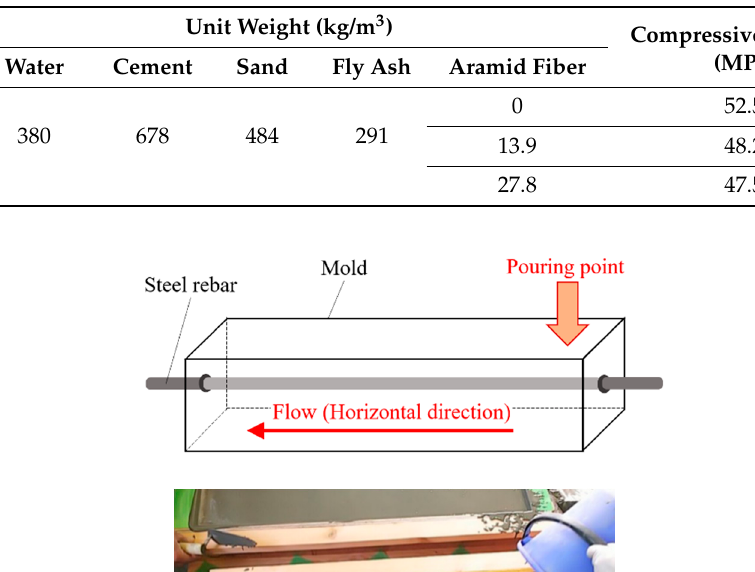
Table 3. Mixture proportion and mechanical properties of FRCC.